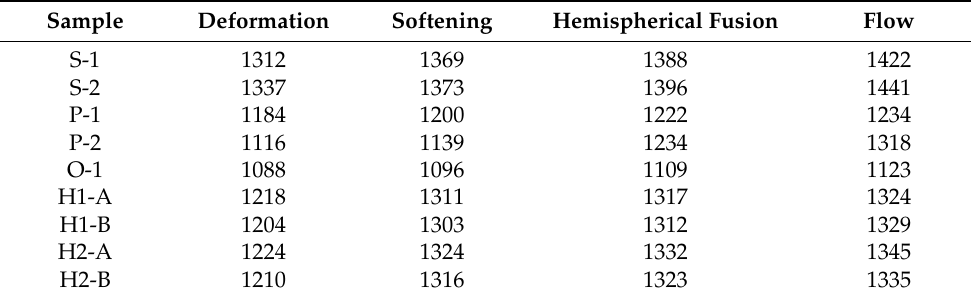
Table 3. The melting temperature of the slags with different furnace charged/ ◦ C. Sample Deformation Softening Hemispherical